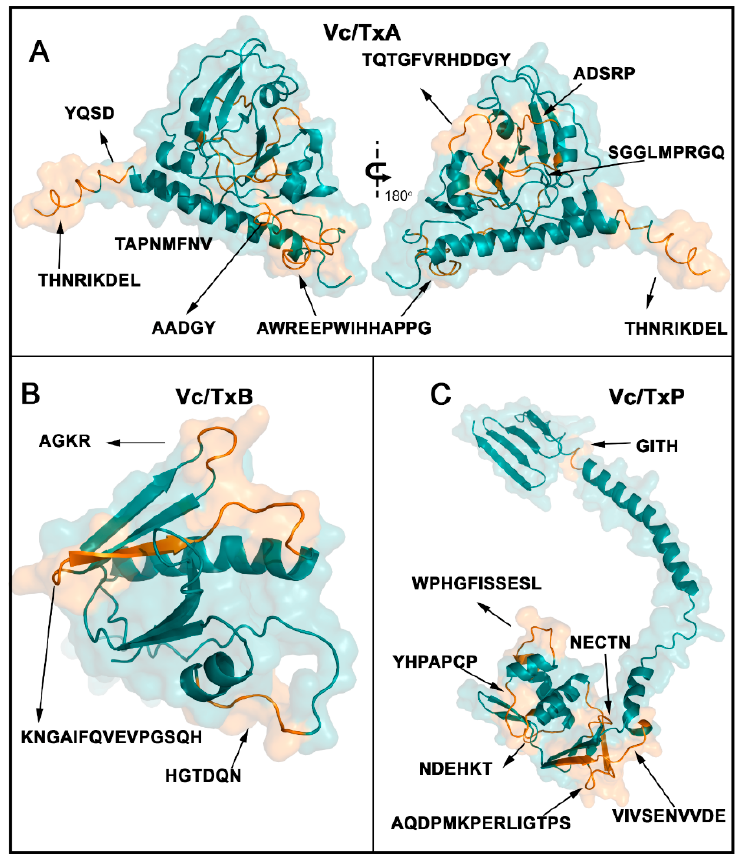
Figure 2. Epitope localization in three-dimensional structures of V. cholerae toxins A ( A ), B ( B ), and P ( C ). Epitopes are presented in orange within models constructed using the crystal structure of toxin A (PDB: 1xtc) and the AlphaFoldDB predicted protein structures of toxins B and P. Images were created using PyMOL.